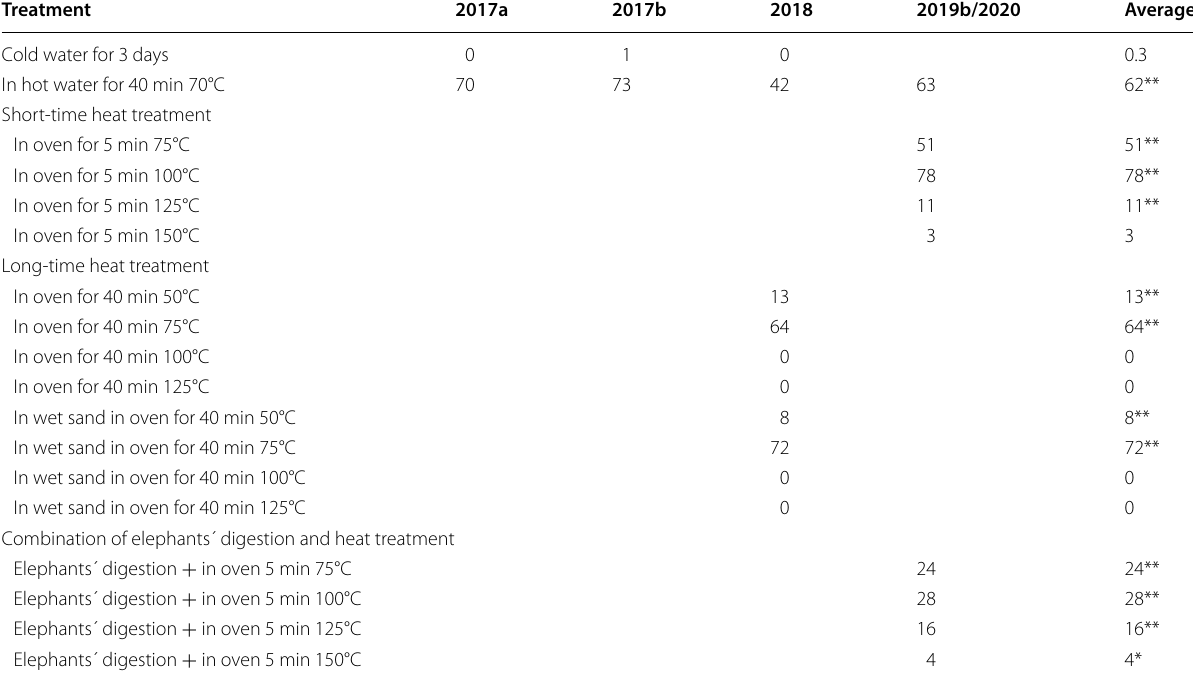
Results obtained in three test setups with 100 seeds per treatment each, except 50 seeds for combination of elephant’s digestion and heat treatment: 2017a, 2017b, 2018 and 2019b. Significant increase of GR compared to the control without treatment are indicated with *P<0.05, **P<0.01